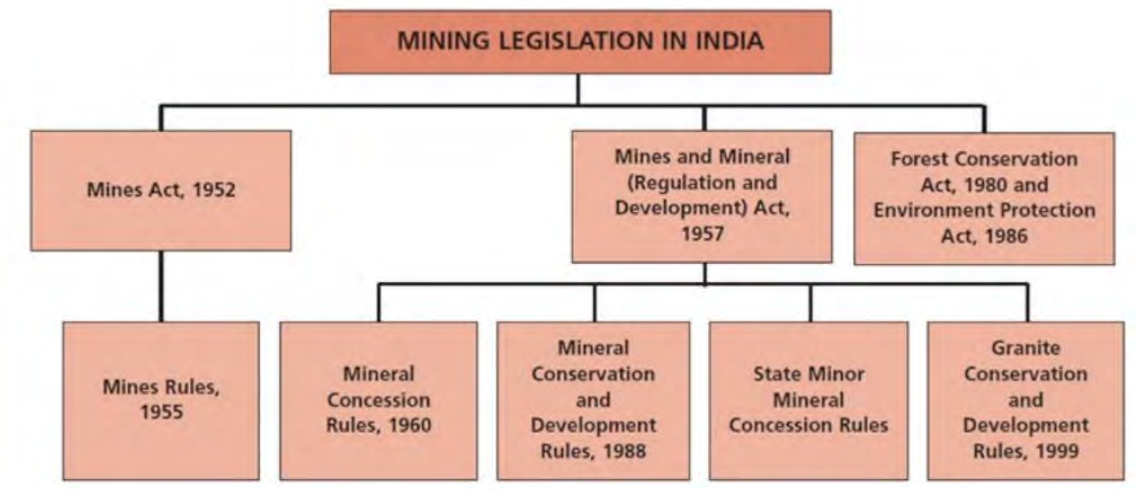
Figure 1. Mining Legislation in